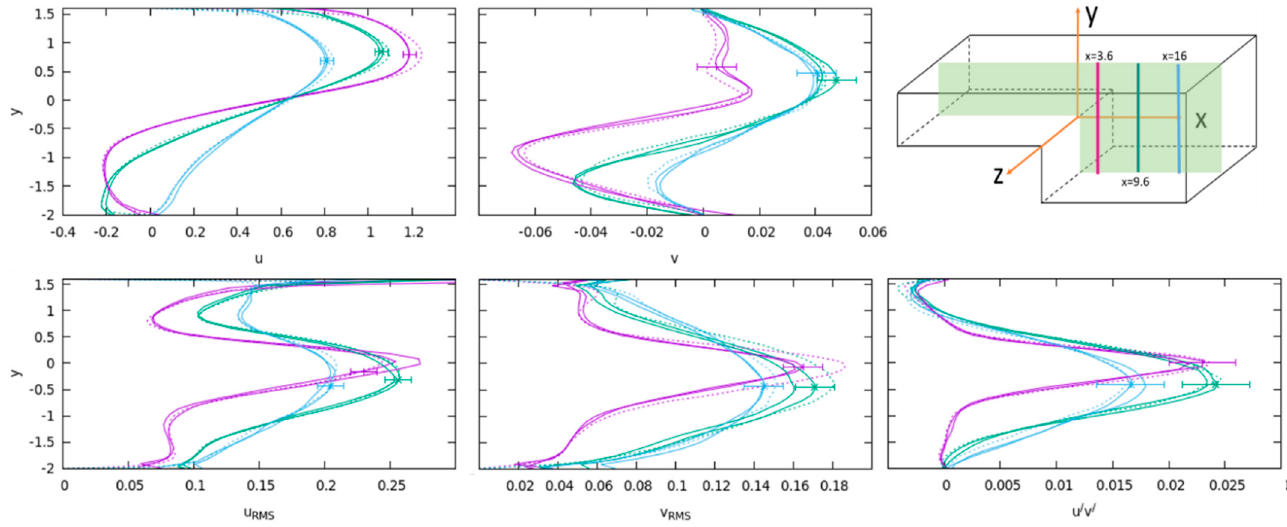
Figure 8. Measurements ‘z − 0’ and ‘z − 0a’. Profiles at x = 3.2, 9.6, 16 mm. Variables: u, v, u RMS , v RMS , and u (cid:48) v (cid:48) . Measurements—solid lines. DNS—dotted lines. Uncertainties are given for ‘z − 0’ measurement in a single point per